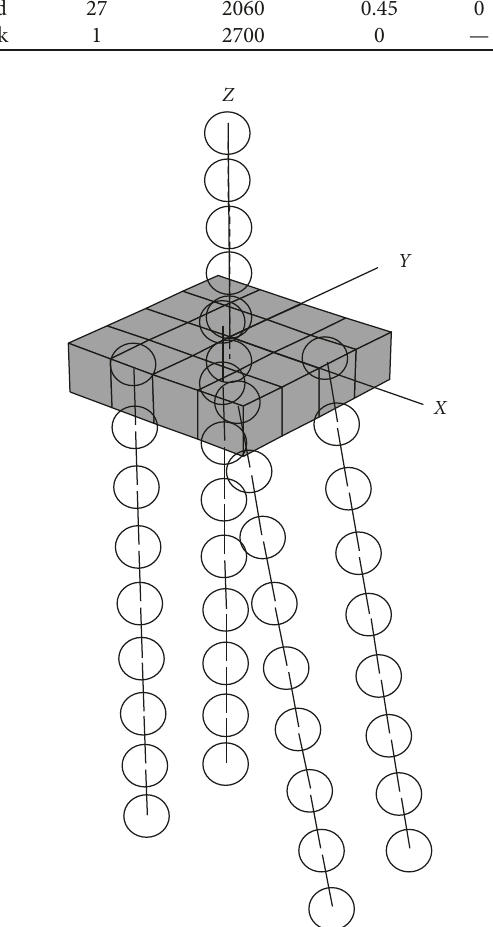
Figure 5: Computational model of the pile group-pile cap-bridge structure system.